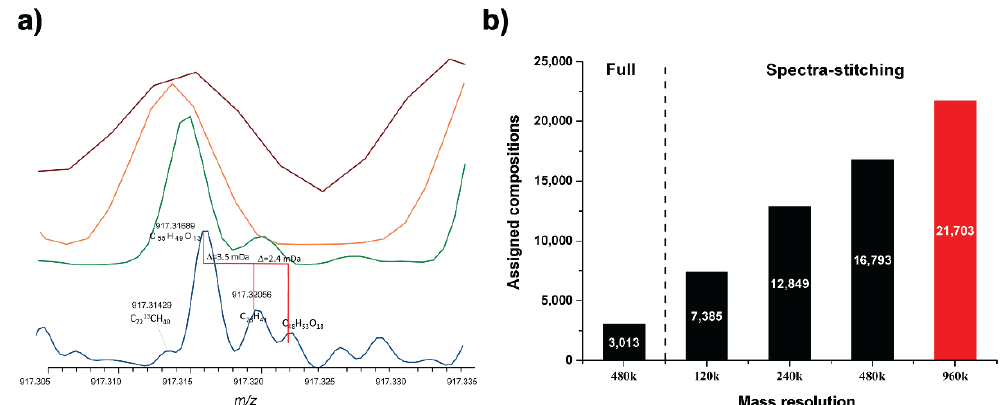
Figure 1. The impact of resolution and scan techniques on the detection of molecular compositions: ( a ) Mass spectra com- parison from m/z 917.305 to 917.335 for resolution settings 120k, 240k, 480k and 960k (from top to down). ( b ) Summarized population distribution of different resolution data on spectral stitching acquisition for resolution settings 120k, 240k and 960k. Shown are important mass splits for biofuels that contain a high number of oxygen atoms; in this case, the mass split between C 18 and H 8 O 13 , which corresponds to a mass difference of 3.5 mDa, and the mass split of C 25 and H 12 O 18 , which shows a difference of 2.5 mDa.